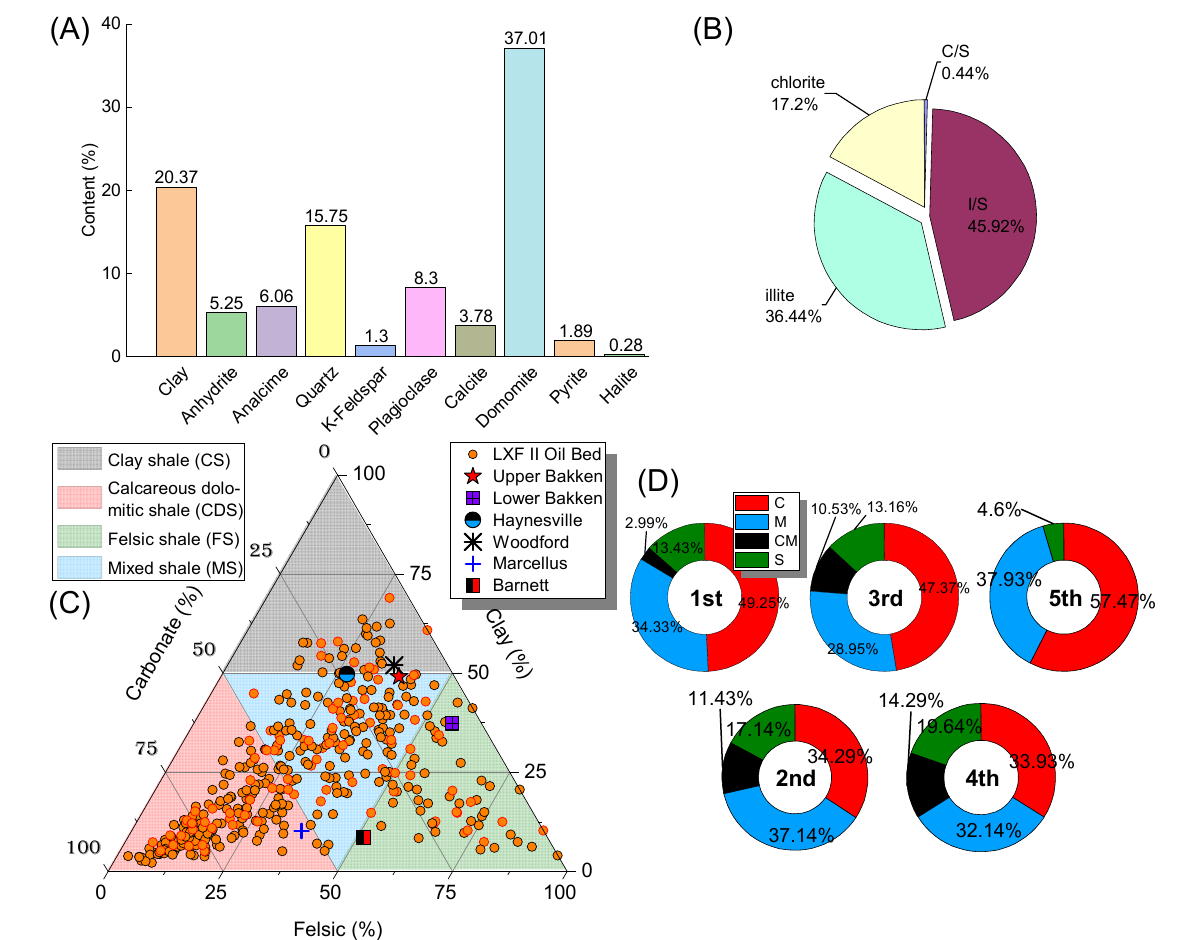
Figure 2. Mineralogical and lithofacies characteristics of the LXF II Oil Bed in the Jianghan Basin. ( A ) The proportion of main minerals. ( B ) Types of clay minerals. ( C ) Ternary diagram of lithofacies division; data for comparison taken from [28,29]. ( D ) The proportion of various lithofacies in different intervals.